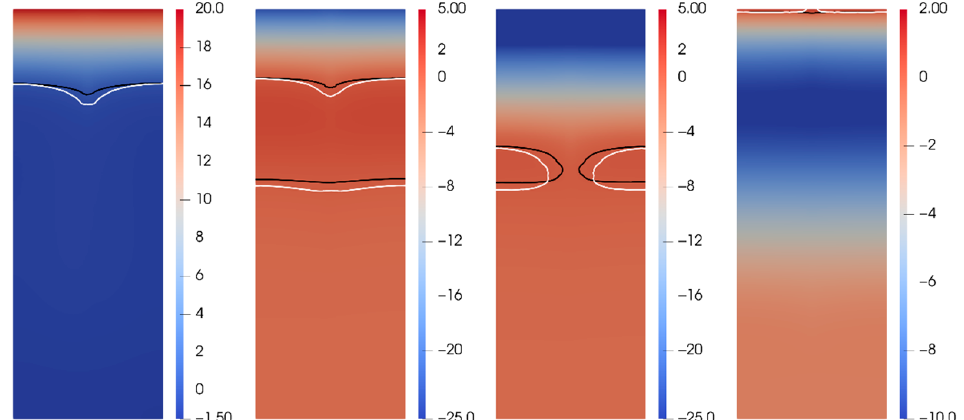
Figure 4. Temperature distribution for different time layers ( t = 50, 200, 250, 365 days) when the fibers are structurally located. From left to right. (white line is isocline of zero of steel, black is isocline of zero of basalt).